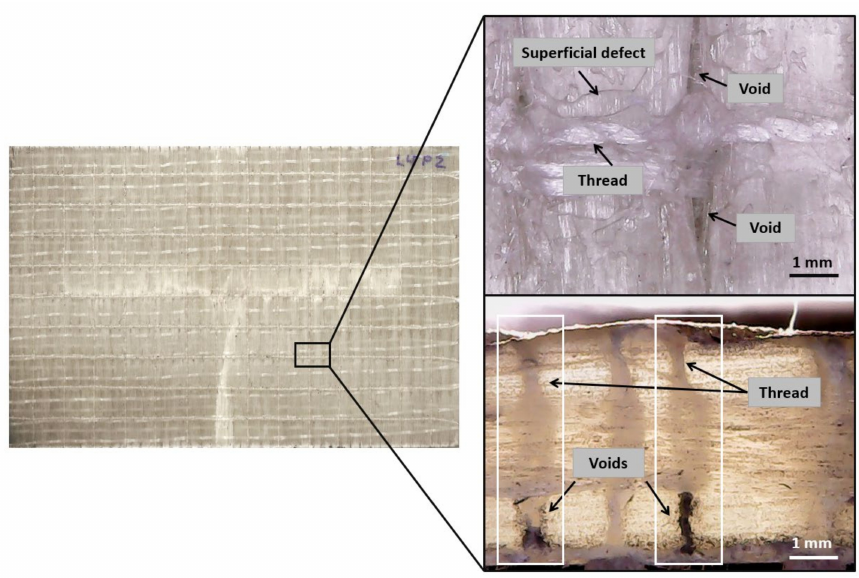
Figure 6. Impregnation defects in stitched laminates. The applied vacuum generates voids around the seams ( top ) and the cross-section of stitched laminate near the stitching point ( bottom